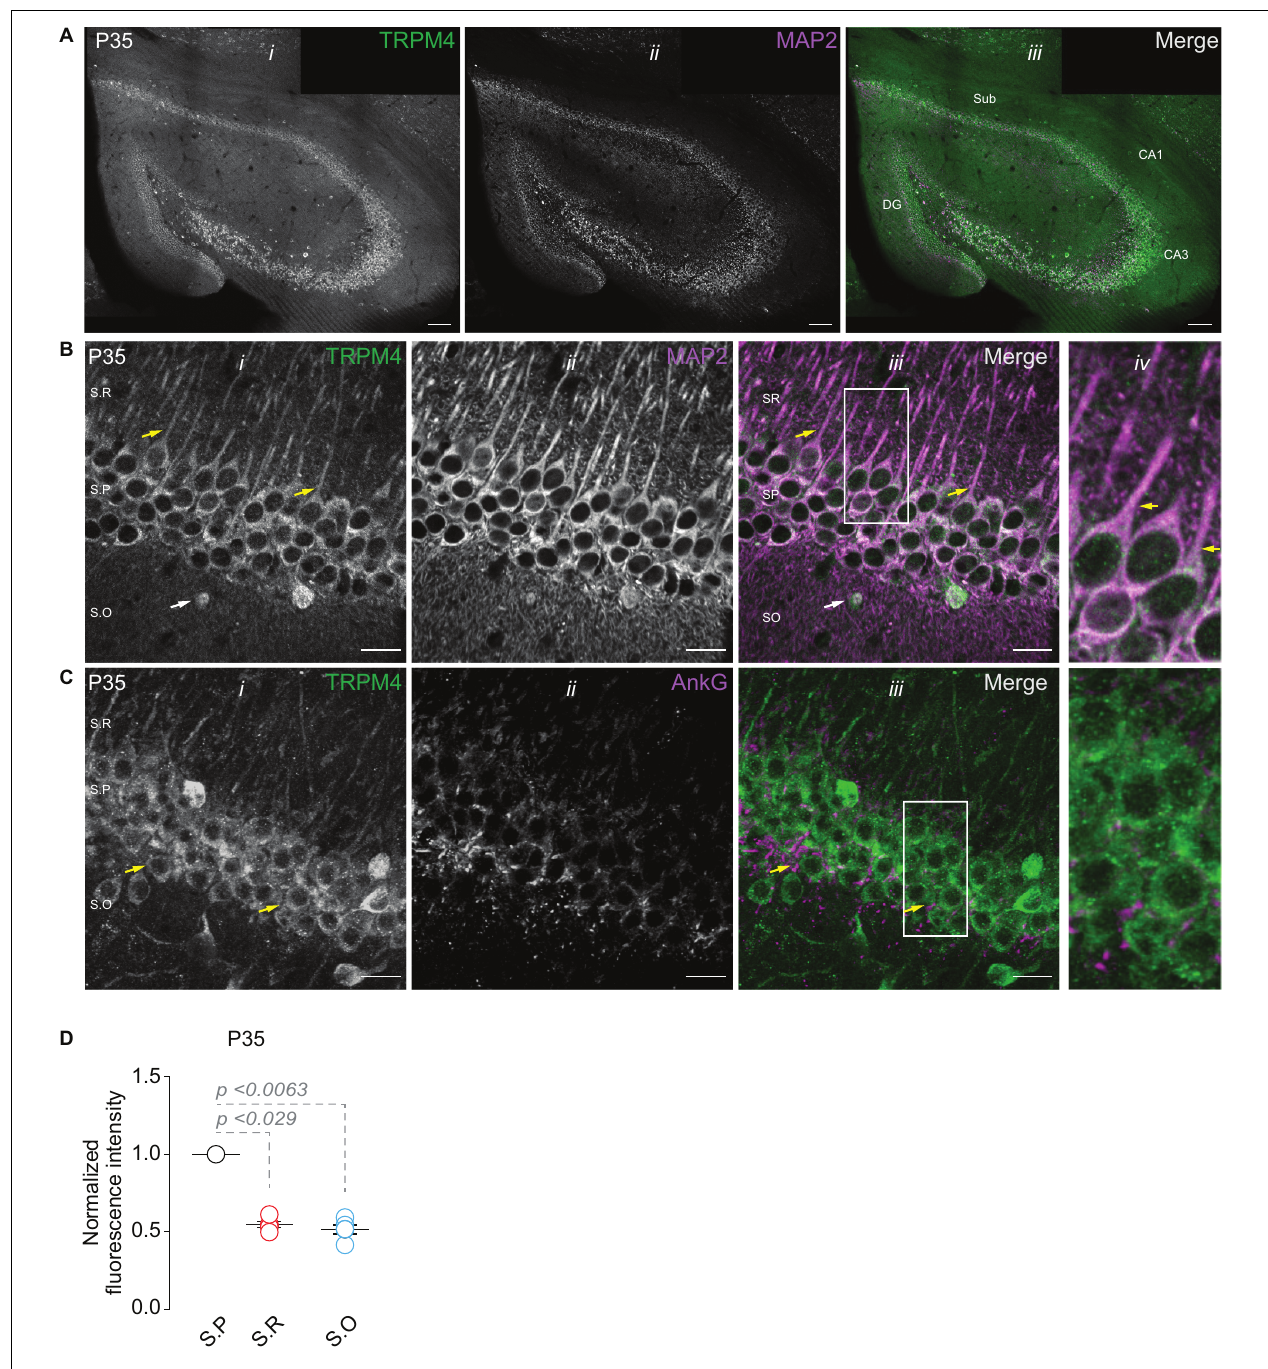
FIGURE 1 | TRPM4 expression in CA1 pyramidal neurons at P35. Confocal images showing double labeling of (A) TRPM4 (Alexa 488, green, i ) with MAP2 (Alexa 546, magenta, ii ), merged signals ( iii ), in the whole hippocampal area. (B) Shows the expression of TRPM4 ( i ) MAP2 ( ii ) and the merged signals ( iii ) in area CA1, and ( iv ) shows a zoomed area (white rectangle); yellow arrowheads show neurons in the stratum pyramidale and the distribution in the soma and proximal apical dendrite, white arrowhead show the distribution in the stratum oriens , showing the expression in the somatic region of the neurons. (C) Shows the expression of TRPM4 (Alexa 488, green, i ) and AnkG (Alexa 546, magenta, ii ) and the merged signals ( iii ), and ( iv ) shows a zoomed area (white rectangle). (D) Graph of normalized fluorescence intensity of TRPM4 in S.P, S.R, and S.O of area CA1. Fluorescence intensity values were normalized to CA1 S.P for each mouse. Each point corresponds to an individual mouse (Kruskal–Wallis followed by Dunn’s post hoc test vs. CA1 S.P; n = 5 mice). S.P, stratum pyramidale ; S.R, stratum radiatum ; and S.O, stratum oriens . Calibration bars = 100 µ m in (A) , and 20 µ m in (B,C) .